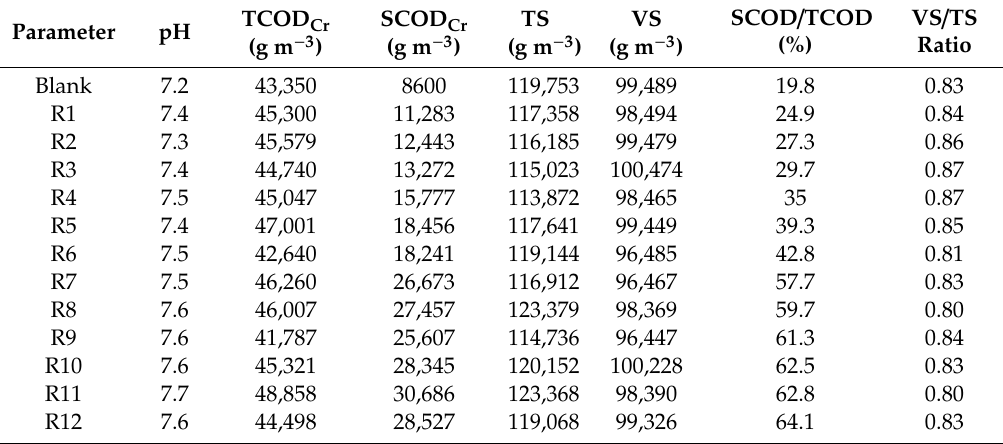
Table 6. Changes in inflow substrate characteristics according to thermal hydrolysis pre-treatment